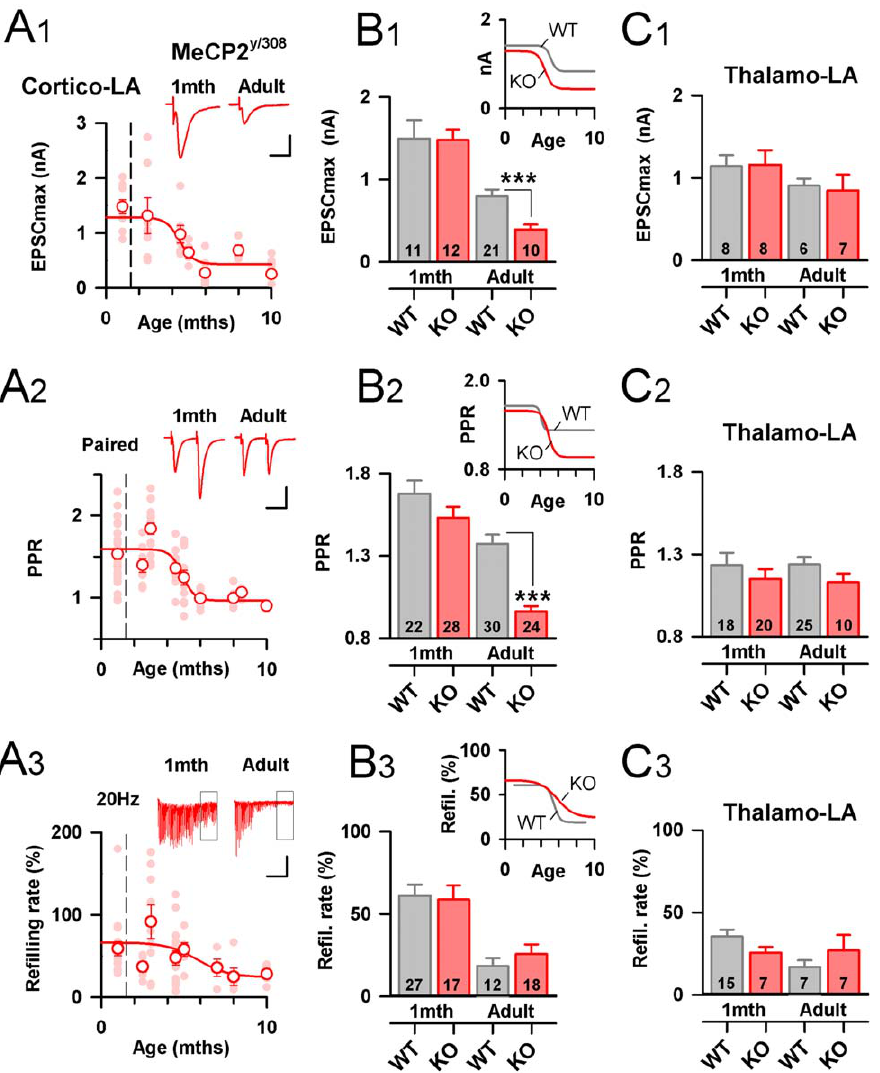
Figure 2. Synaptic maturation and elimination at excitatory projections to the LA in Mecp2 deficient mice. A 1–3 : Developmental time course of EPSCmax, PPR and refilling rateat Cortico-LA synapses of Mecp2 308/Y KO mice. Light red circles represent single experiments and white dots are mean ( 6 SEM) values at a given post-natal age. Top: typical traces. Scale bars: A 1 : 1 nA and 10 msec. A 2 : 50 pA and 0.5 sec, A 3 : 100 pA and 1 sec. B 1–3 : Bar graphs summarizing the EPSCmax (B 1 ), PPR (B 2 ) and refilling rate (C 3 ) at Cortico-LA synapses in juvenile (1 month) and adult ( . 6 months) KO mice. The number of recorded cells is indicated. *: p , 0.05, ***:p , 0.001. Right: Evolution of synaptic parameters during development. C 1–3 : Same presentation as in B 1–3 , but for Thalamo-LA synapses.